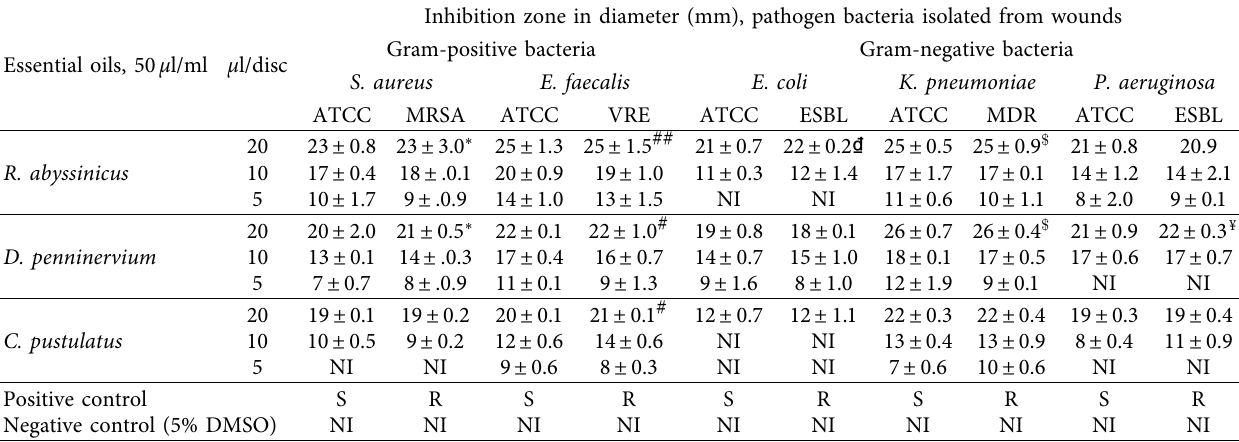
Table 2: Inhibition zone (mm) of essential oils against MDR bacteria isolated from wounds at KMU, 2020. Inhibition zone in diameter (mm), pathogen bacteria isolated from Essential oils, 50 μ l/ml μ l/disc